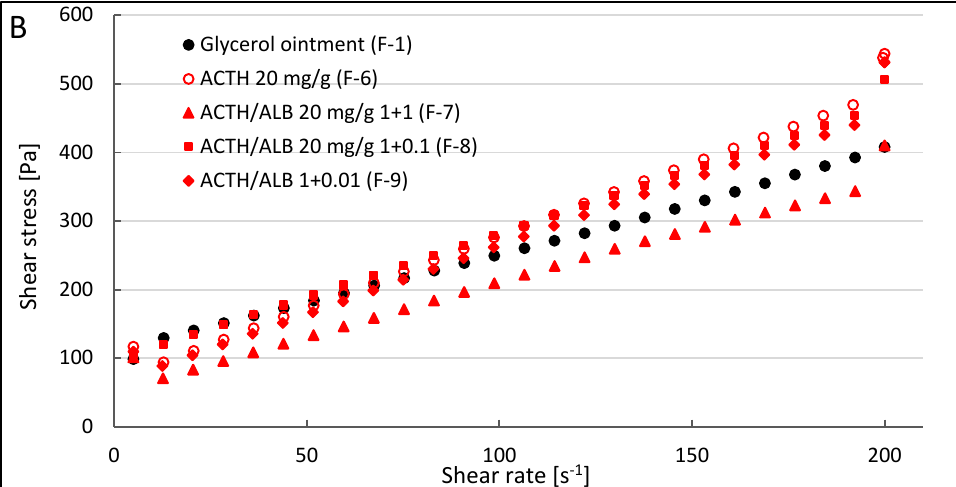
Figure 5. Flow curves for formulations containing ACTH at concentration 15 mg/g (F-2) and ACTH at concentration 15 mg/g and albumin (F-3–F-5) ( A ) and for formulations containing ACTH at concentration 20 mg/g (F-6) and for formulations containing ACTH at concentration 20 mg/g and albumin (F-7–F-9) ( B ) with regard to Glycerol hydrogel-F-1, n = 5. The relatively small area formed between ascending and descending curves indicated good regeneration of the systems (Figure 6A,B). A system with good regeneration could increase adhesion on the skin and thus maintain a better therapeutic effect.